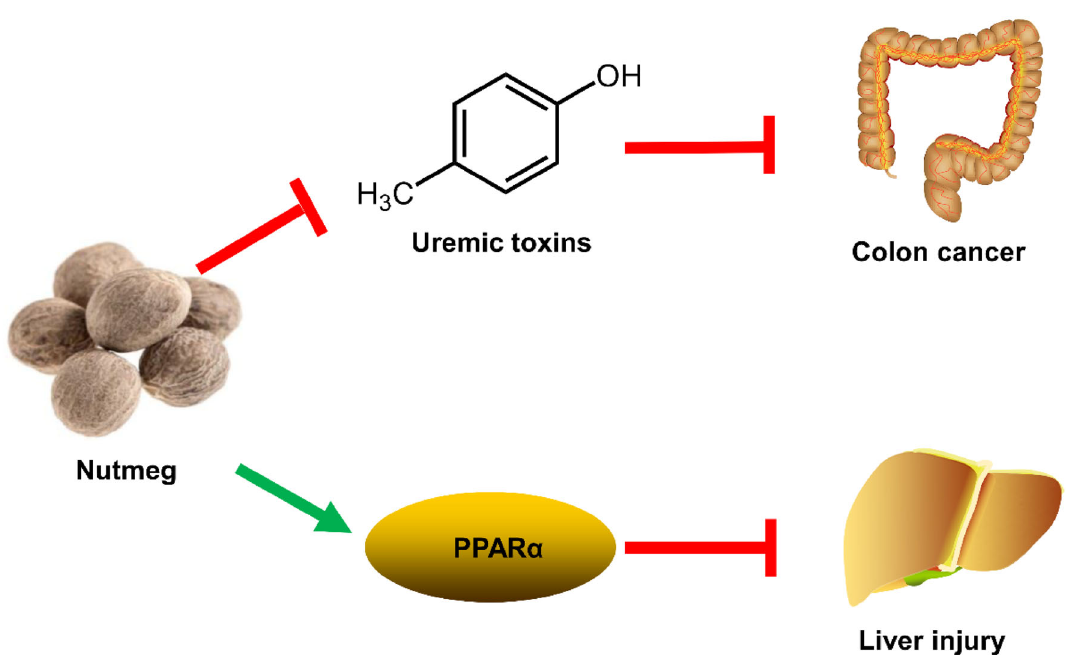
Fig. 7 Modulation of colon cancer and liver injury by